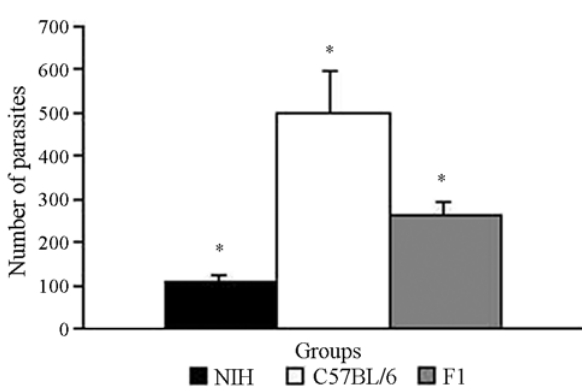
Figure1 -Numberof S.venezuelensis parthenogeneticfemalesrecovered from the first third of the small intestines of NIH, C57BL/6 and F1 mice infected with 2000 larvae. (*) Significantly different, p < 0.05 (PROC GLM- SAS ® , 2001, version 8). Vertical bars indicate the standard error.